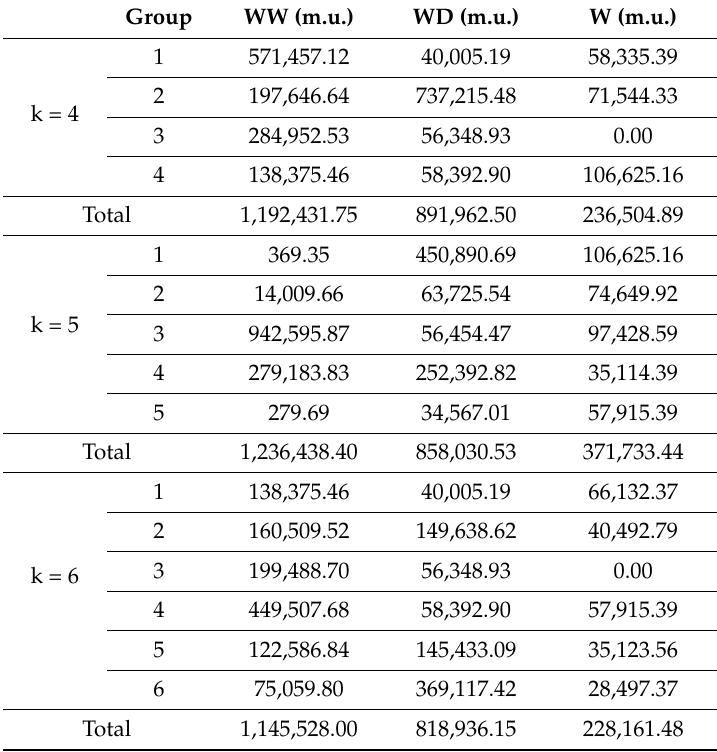
Table 7. Final Remuneration for k = 4 to k = 6. Group WW (m.u.) WD (m.u.) W